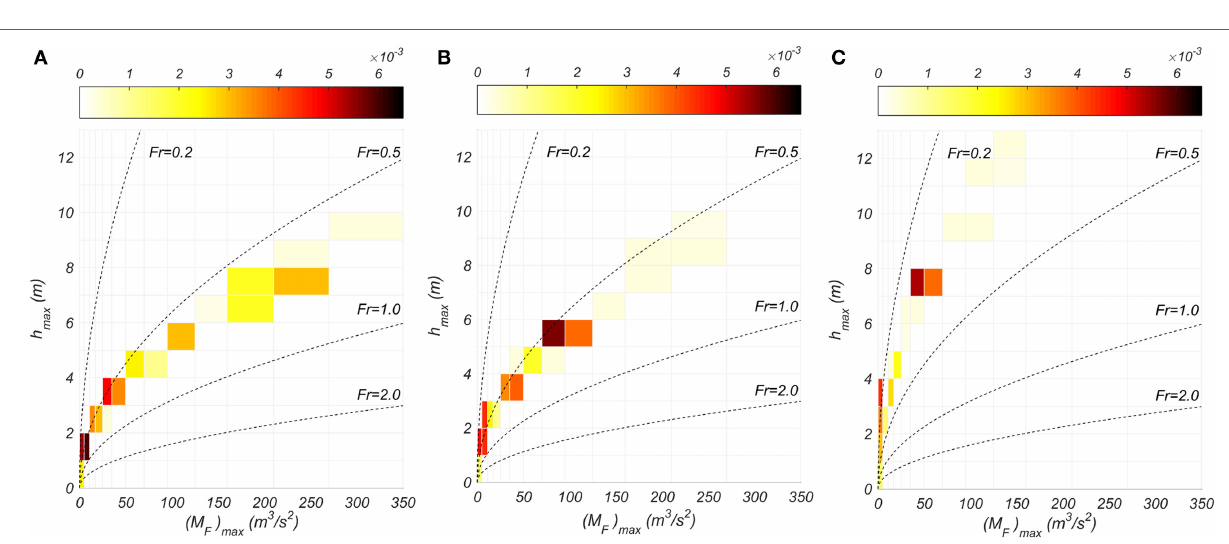
FIGURE 11 | Joint MAR of h max and ( M F ) max with Froude number ( Fr ) (dash lines) at (A) Point 1, (B) Point 2, and (C) Point